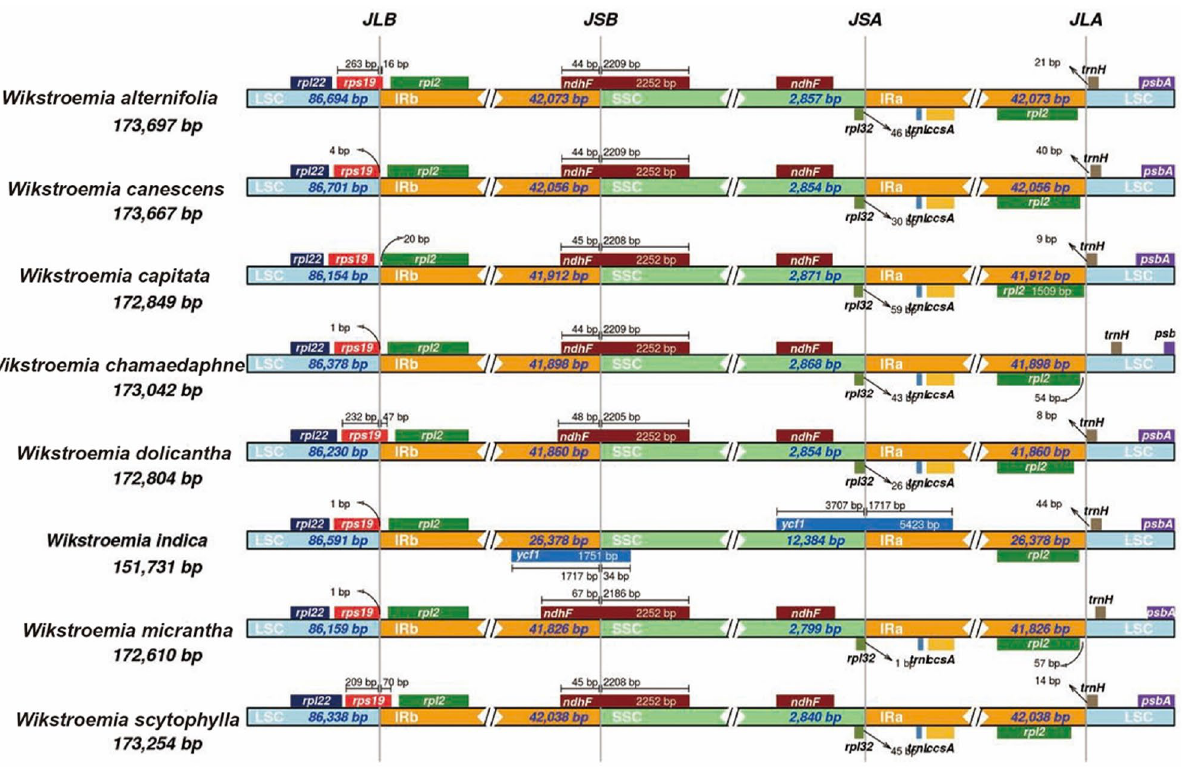
Figure 6. Comparison of borders between LSC, SSC and IR regions across the plastomes of eight species of Wikstroemia . Image was generated with IRscope 50